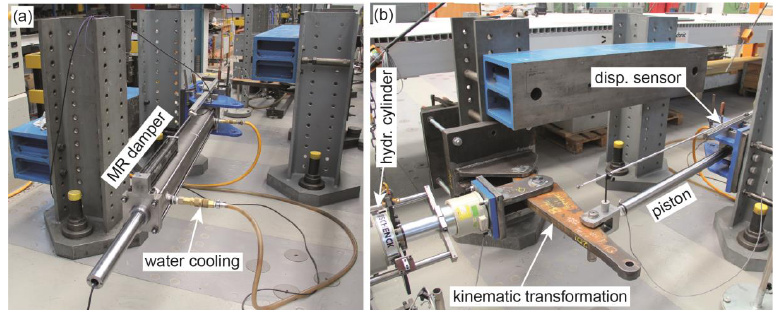
Figure 19. Hybrid testing of MR dampers of Danube City Tower: ( a ) MR damper with water cooling system and ( b ) kinematic transformation to perform hybrid tests at realistic displacement amplitudes.